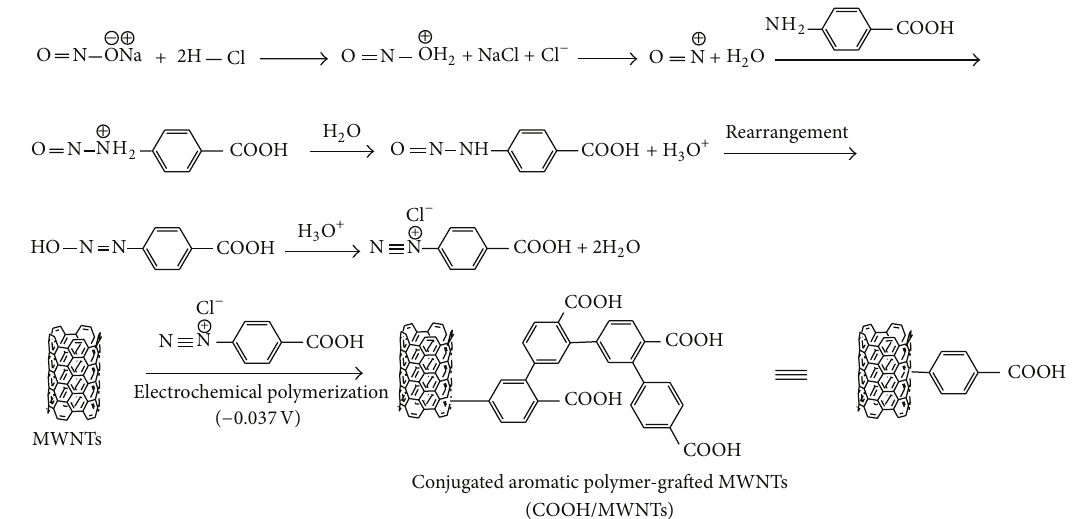
Figure 2: Possible synthesis mechanism of the conjugated aromatic polymer-grafted MWNTs using 4-carboxyphenyl diazonium salts.